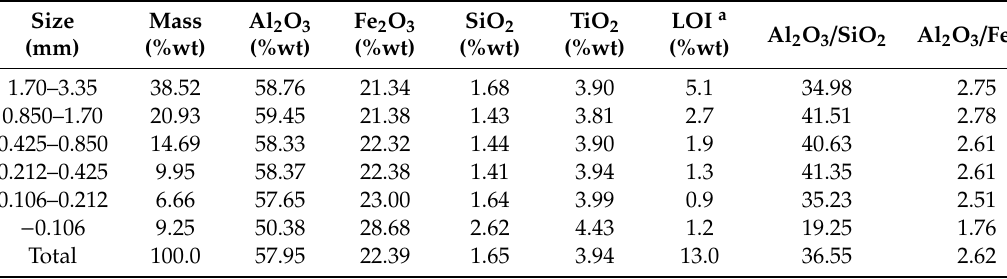
Table 2. Chemical composition of each bauxite fraction obtained after sieving.